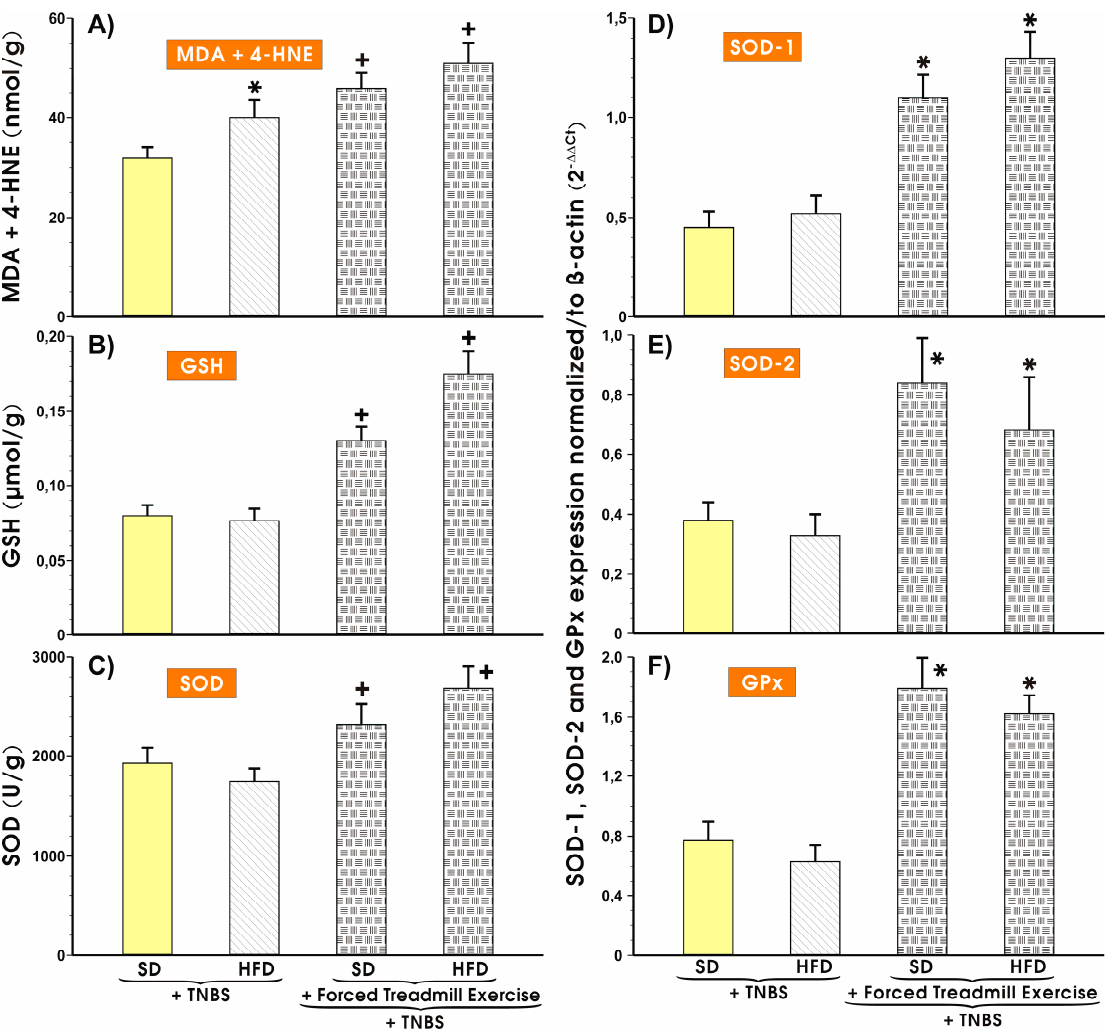
Figure 4. The colonic mucosal content of malondialdehyde (MDA) and 4-hydroxynonenal (4-HNE) ( A ), the reduced glutathione (GSH) ( B ), the activity of superoxide dismutase (SOD) ( C ) and the results of mRNA expression of SOD-1 ( D ), SOD-2 ( E ), and GPx ( F ) in colonic mucosa of sedentary mice with colitis fed SD or HFD with or without forced treadmill exercise. Results are Mean ± S.E.M. of 6 animals per each experimental group. An asterisk indicates a significant change ( p < 0.05) as compared to respective values obtained in sedentary mice fed SD or HFD. Cross indicates a significant change ( p < 0.05) as compared with respective values in sedentary mice fed SD or HFD.